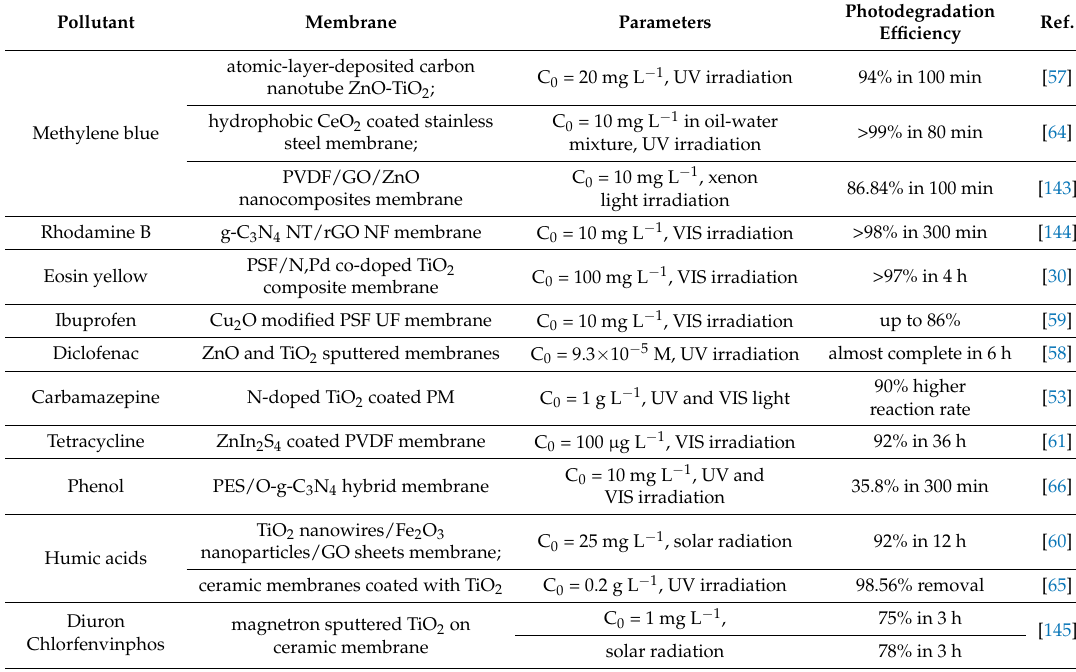
Table 2. Selected examples of application of PMs in removal of organic contaminants from water. Pollutant Membrane Parameters